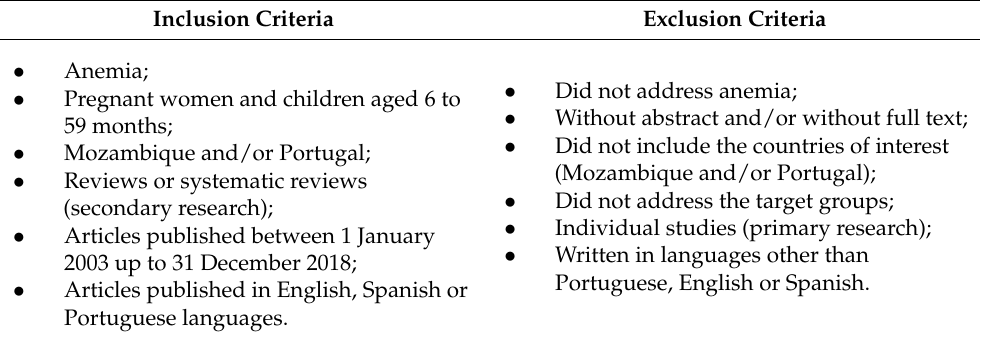
Table 2. Eligibility criteria used for inclusion and exclusion of